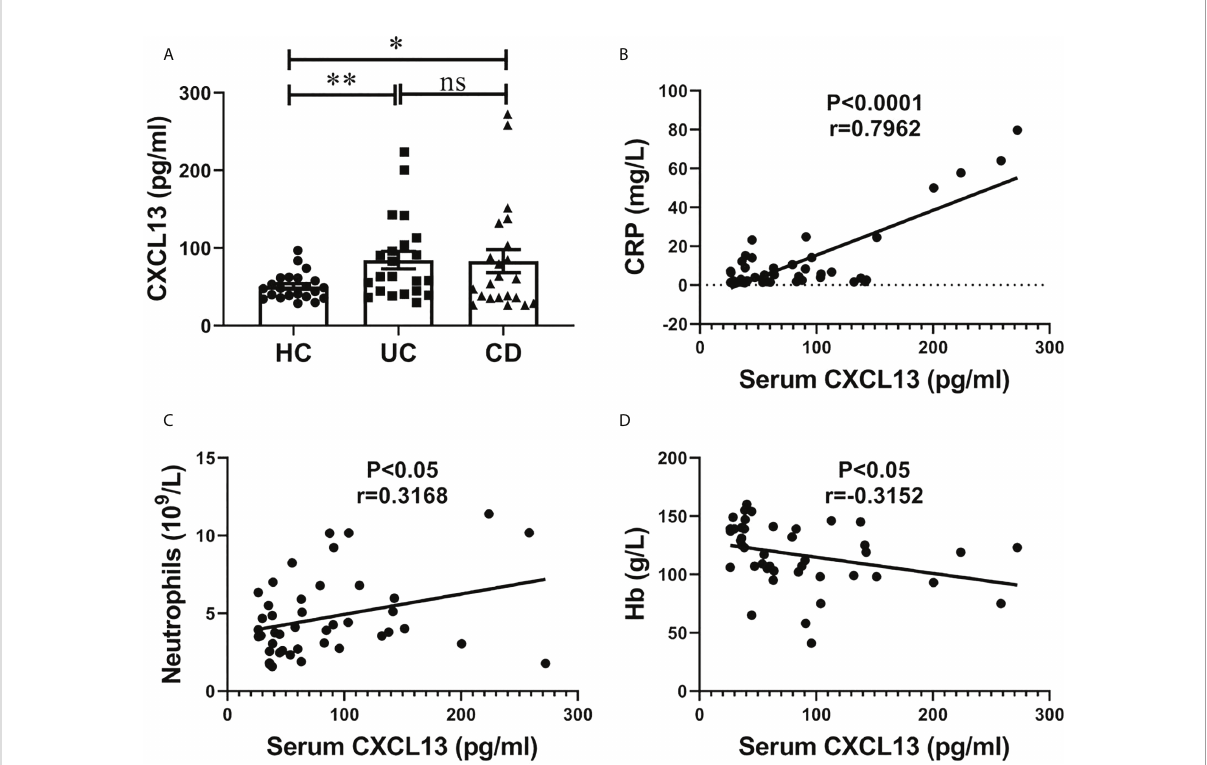
FIGURE 1 Serum CXCL13level was correlated with the severity of in fl ammatory response in patients with IBD. (A) ELISA analysis of CXCL13in serum of IBD patients and healthy controls (n=22/group). Data arepresented as mean ± SEM,with P values determined by two-tailed Student ’ s t test. (B – D) Correlation between serum CXCL13levels and C-reactive protein, neutrophils counts, hemoglobin wereassessed in clinical IBD patients. Statistically signi fi cant correlations weredetermined using linearregression. These experimental data indicate that CXCL13is signi fi cantly elevated in the serum of IBD patients, and its expression is positivelycorrelated withthe degree of in fl ammatory response.* P < 0.05; ** P < 0.01. ns, notstatistically signi fi